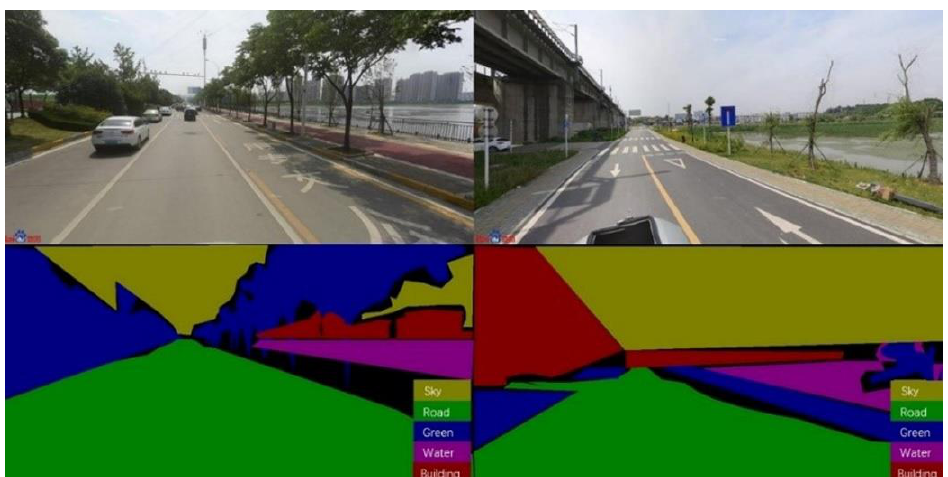
Figure 8. Schematic diagram of PSPNet model.